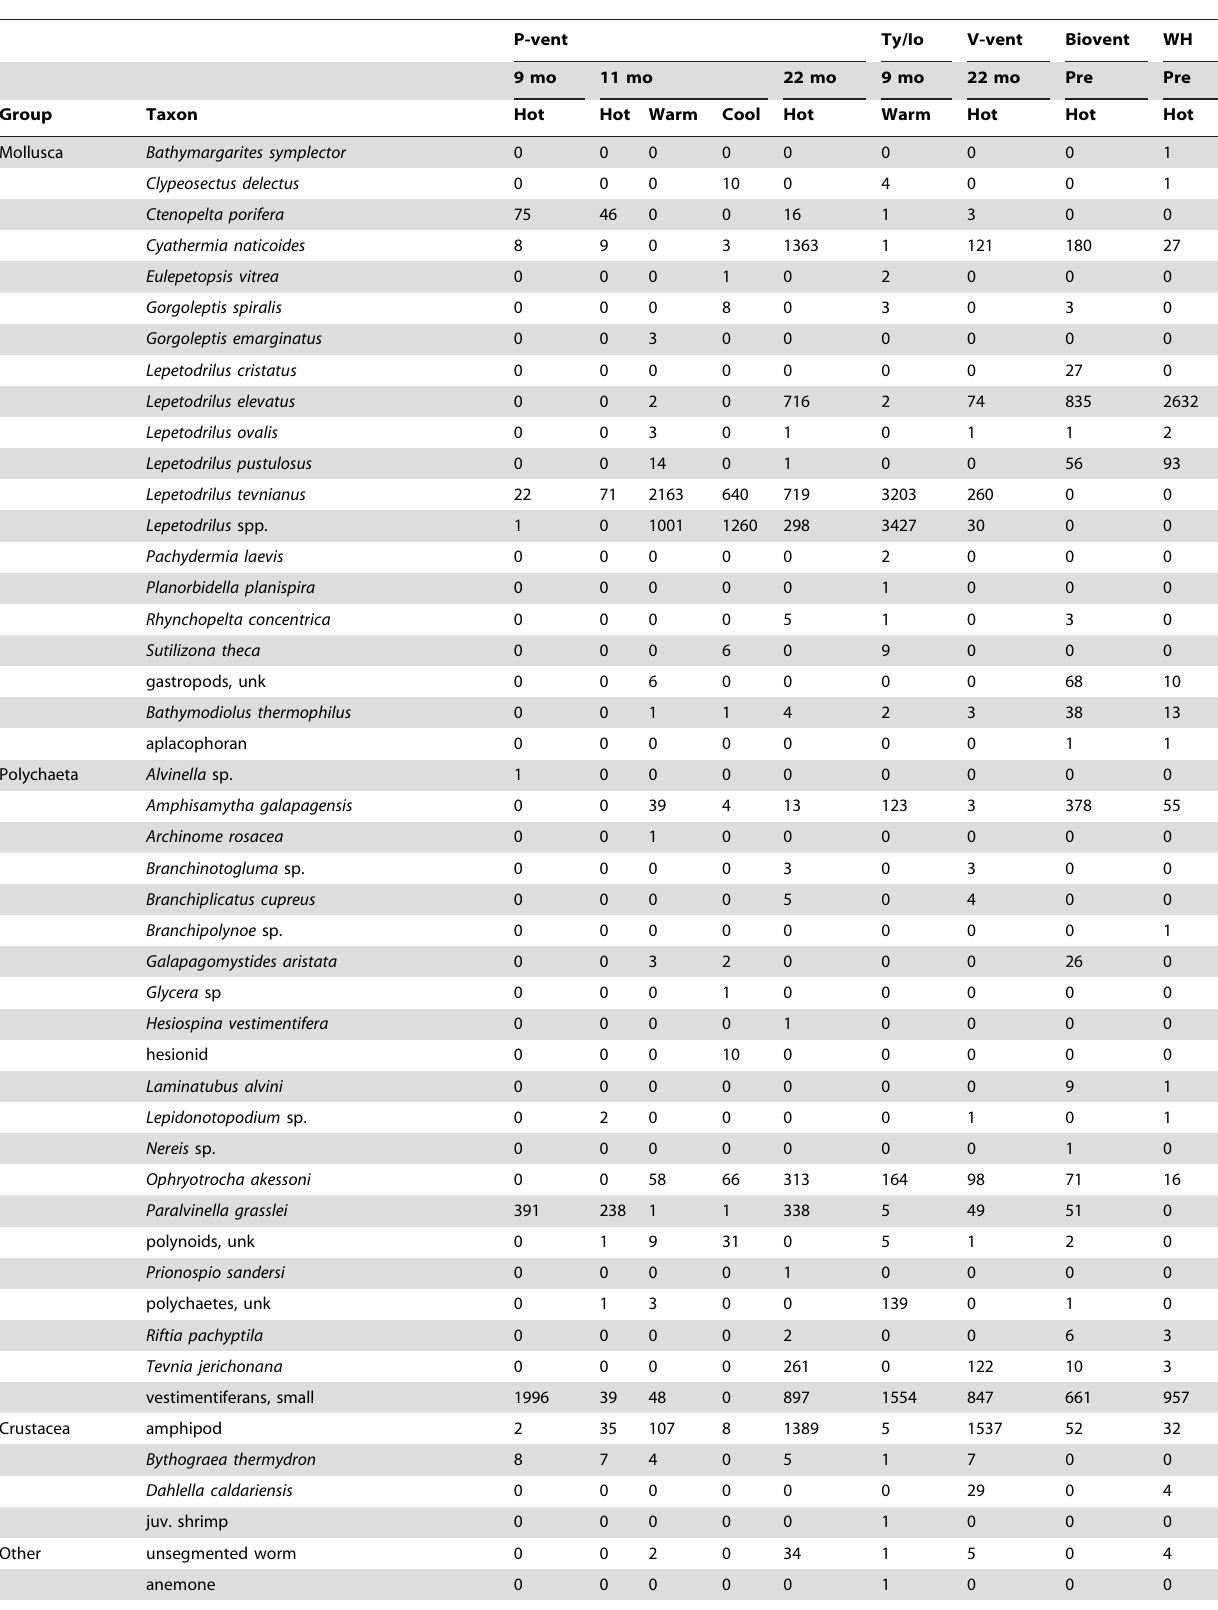
Table 3. Abundance of species (taxa) on colonization surfaces at different sites, times and environments.